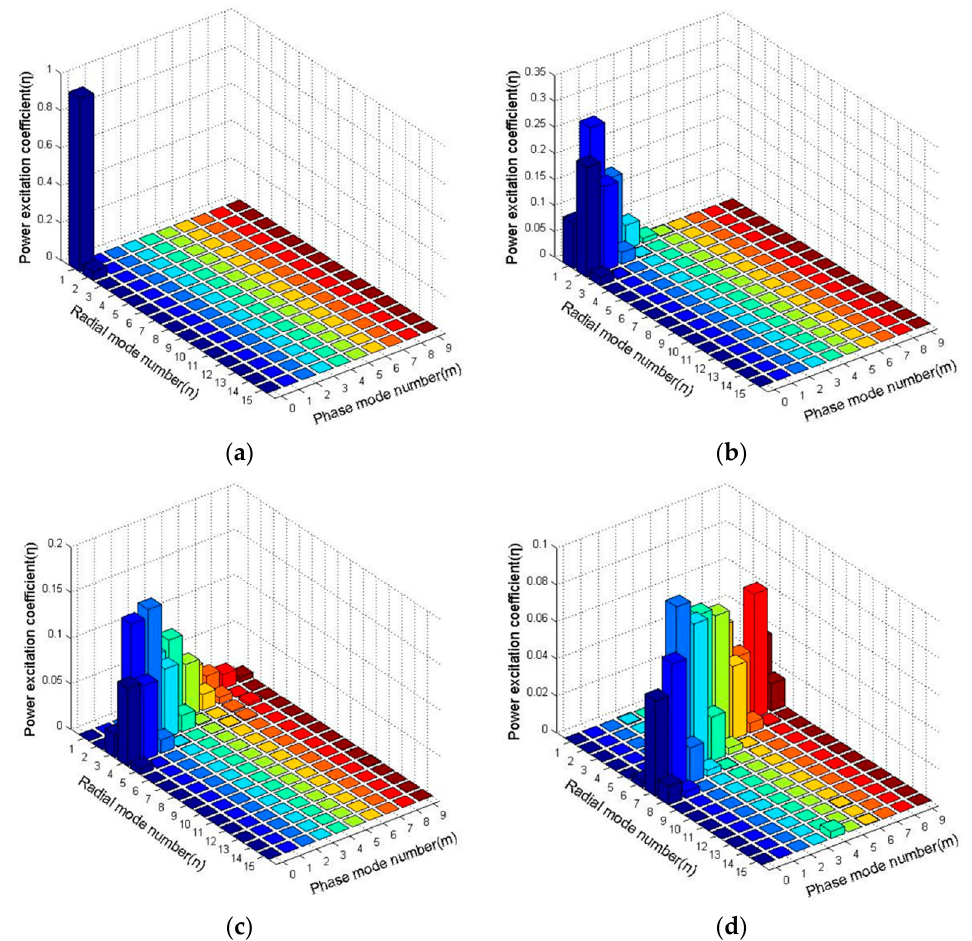
Figure 1. The modal power distributions under various excitation conditions (by varying the tilt angle θ of the Gaussian beam): ( a ) θ = 0°; ( b ) θ = 0.2°; ( c ) θ = 0.5°; ( d ) θ = 1°.